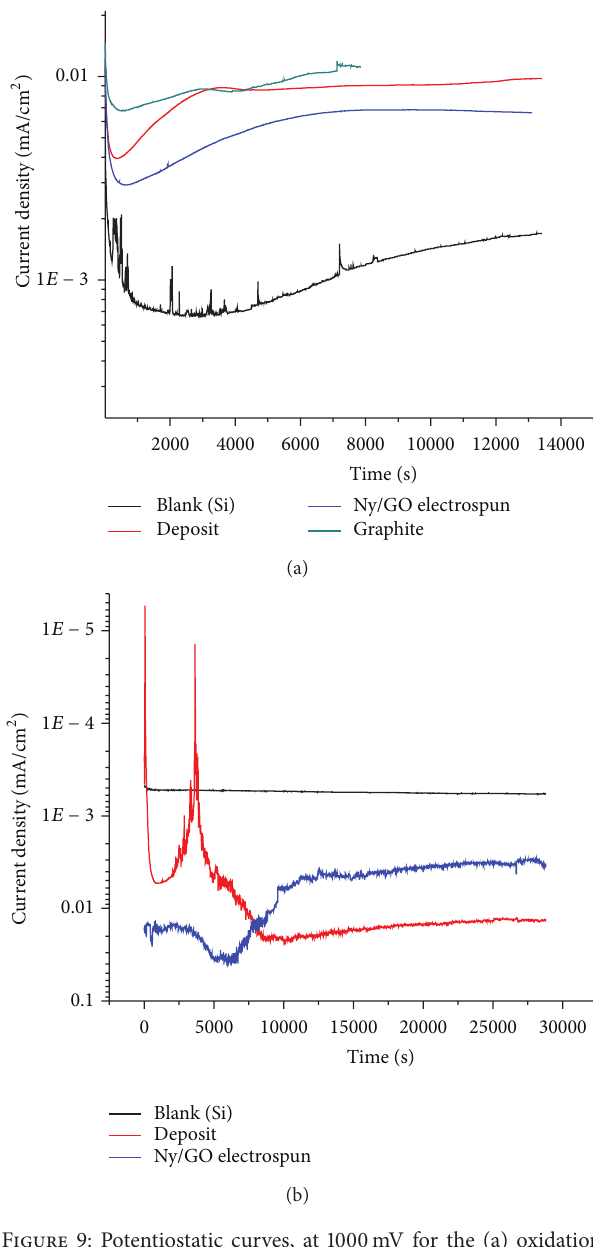
Figure 9: Potentiostatic curves, at 1000 mV for the (a) oxidation of the Ny/GO in basic KOH, 0.5 M solution during 3.5 hr and (b) reduction of the Ny/GO in H 2 SO 4 , pH 2 solution during